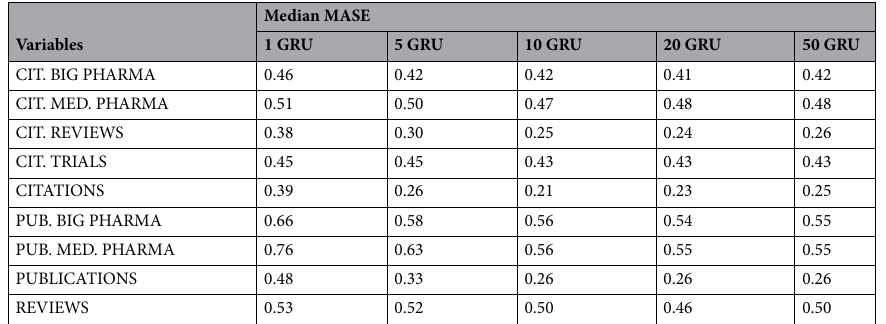
Table 8. Model size comparison. Global performance of the RNN model. Mean accuracy scaled error (MASE) is an unbiased method to compare time-series prediction models by comparing how much each model out- performs a naive model that repeats the last value. Values below 0 indicate that the method performs better than the naive model. Data for 13,380 human